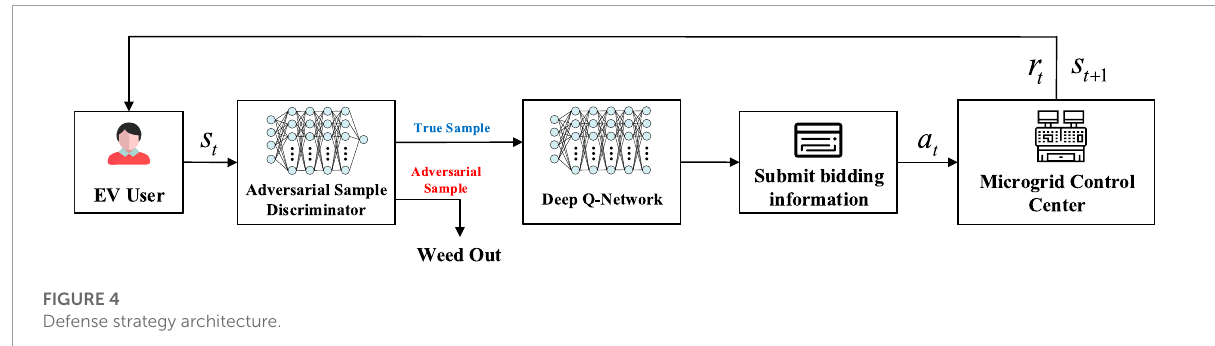
FIGURE 4 Defense strategy